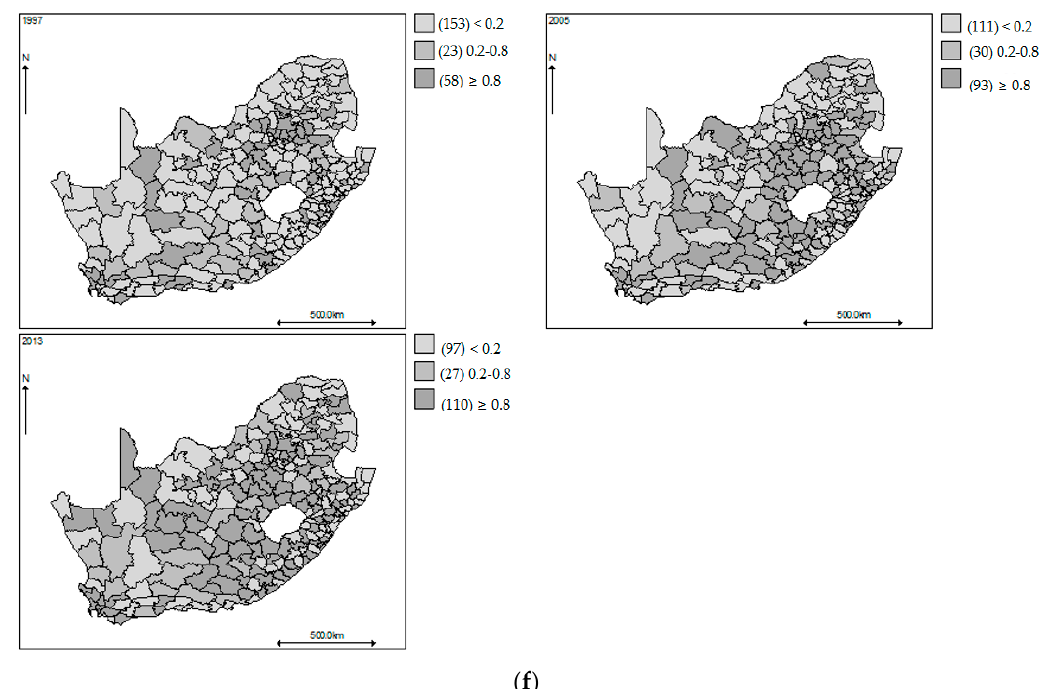
Figure 3. ( a ) Mapped posterior probability that the all ‐ cause smoothed standardized mortality ratios for males aged 0–14 years exceed 1 in 1997, 2005, and 2013, South Africa; ( b ) Mapped posterior probability that the all ‐ cause smoothed standardized mortality ratios for males aged 15–64 years exceed 1 in 1997, 2005, and 2013, South Africa; ( c ) Mapped posterior probability that the all ‐ cause smoothed standardized mortality ratios for males aged 65 years or over exceed 1 in 1997, 2005, and 2013, South Africa; ( d ) Mapped posterior probability that the all ‐ cause smoothed standardized mortality ratios for females aged 0–14 years exceed 1 in 1997, 2005, and 2013, South Africa; ( e ) Mapped posterior probability that the all ‐ cause smoothed standardized mortality ratios for females aged 15–64 years exceed 1 in 1997, 2005, and 2013, South Africa; ( f ) Mapped posterior probability that the all ‐ cause smoothed standardized mortality ratios for females aged 65 years or over exceed 1 in 1997, 2005, and 2013, South Africa.